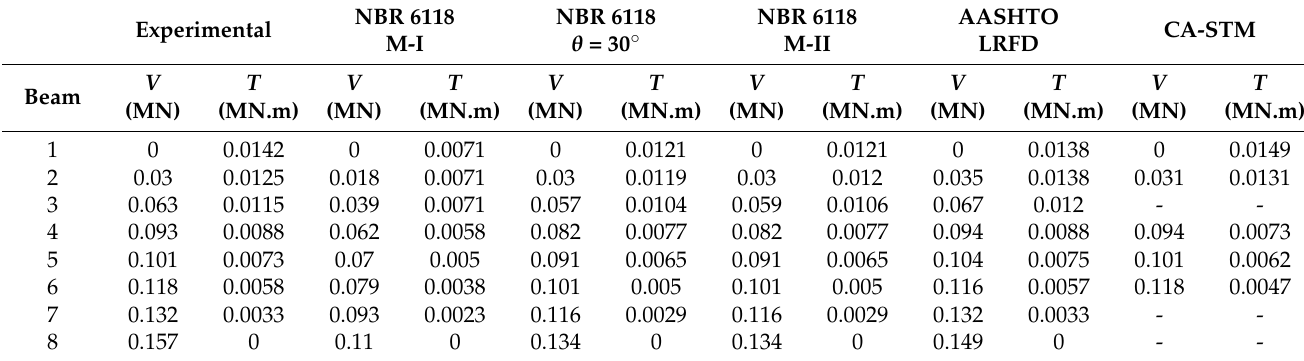
Table 4. Results for RC beams from Series 2.